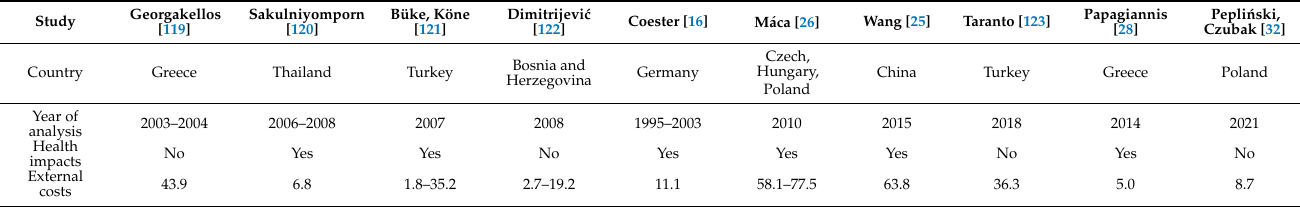
Table 9. External costs of air pollution caused by lignite combustion and opencast coal mining € × MWh − 1.